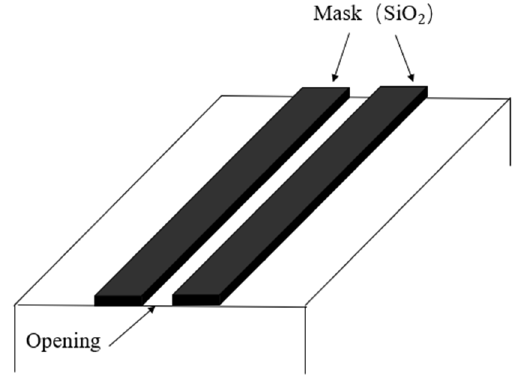
Figure 1. A pair of oxide strips pattern mask for selective area epitaxy.